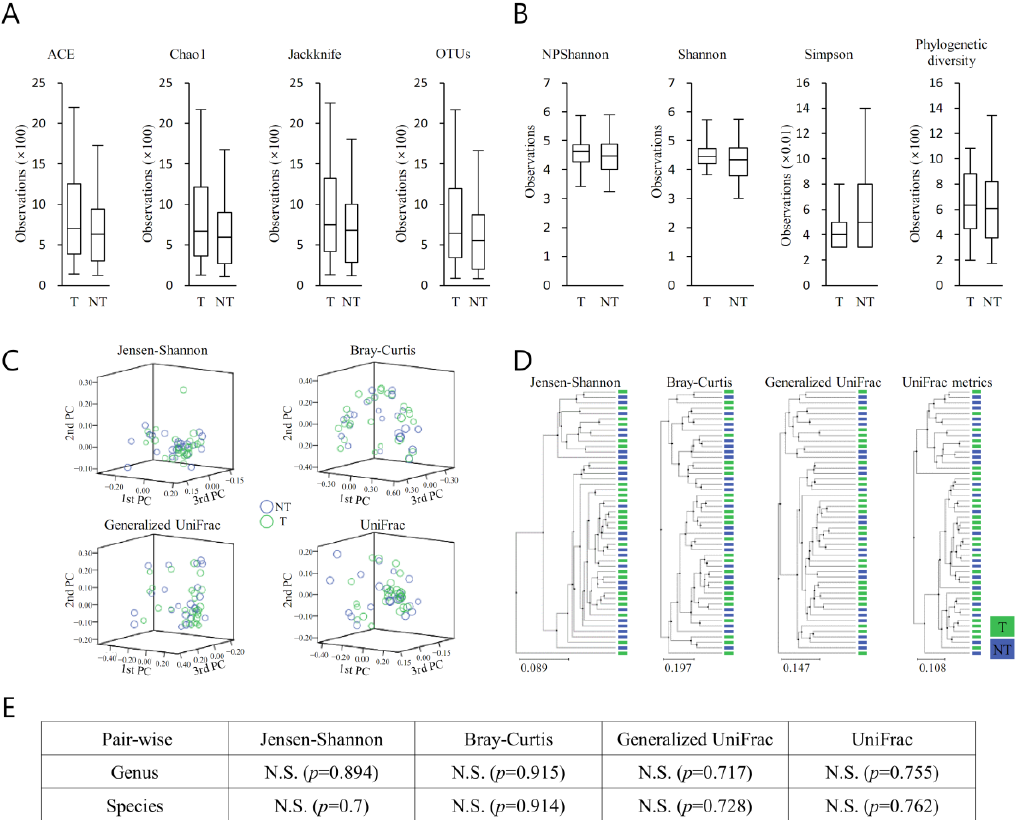
Figure 3. Alpha and beta diversity indices in malignant prostate cancer tissues (MT) and peri-malignant benign prostatic tissues (BT) of prostate cancer patients. ( A ) Species richness was analyzed with Ace, Chao1, Jackknife, and OTUs, ( B ) and the species diversity was analyzed with NPShannon, Shannon, Simpson, and phylogenetic diversity. The horizontal thick black band represents the me- dian value, and the boxplot margins indicate first and third quartiles. None of the alpha diversity analysis results showed a significant difference. ( C ) Distances between communities were analysed by a principal coordinate analysis (PCoA). ( D ) Clustering using the unweighted pair group method with arithmetic mean (UPGMA) was analysed. ( E ) Beta set-significance was demonstrated by per- mutational multivariate analysis of variance (PERMANOVA). Beta diversity analysis was per- formed using Jensen – Shannon, Bray – Curtis, Generalized UniFrac, and UniFrac metrics. N.S., not significant. 3.5. Richness and Diversity (MP vs. BPH) The richness of the bacterial community in MT samples increased compared with that of the BP samples (Figure 4A) ( p < 0.05). The diversity of the bacterial community in BP samples increased compared with that of the MT samples (Figure 4A) ( p < 0.05). They demonstrated remarkable differences between the bacterial communities in the groups (Figure 4C) ( p < 0.05). Spots representing MT samples presented more dispersed distribution patterns than those of BP samples, aligning with the increased level of bacterial diversity found in the cancer samples ( p < 0.05). Beta set-significance was demonstrated by permutational mul- tivariate analysis of variance (PERMANOVA) (Figure 4D). Beta diversity analysis was performed using Jensen – Shannon, Bray – Curtis, Generalized UniFrac, and UniFrac met- rics, demonstrating significant differences (Figure 4E) ( p < 0.05).